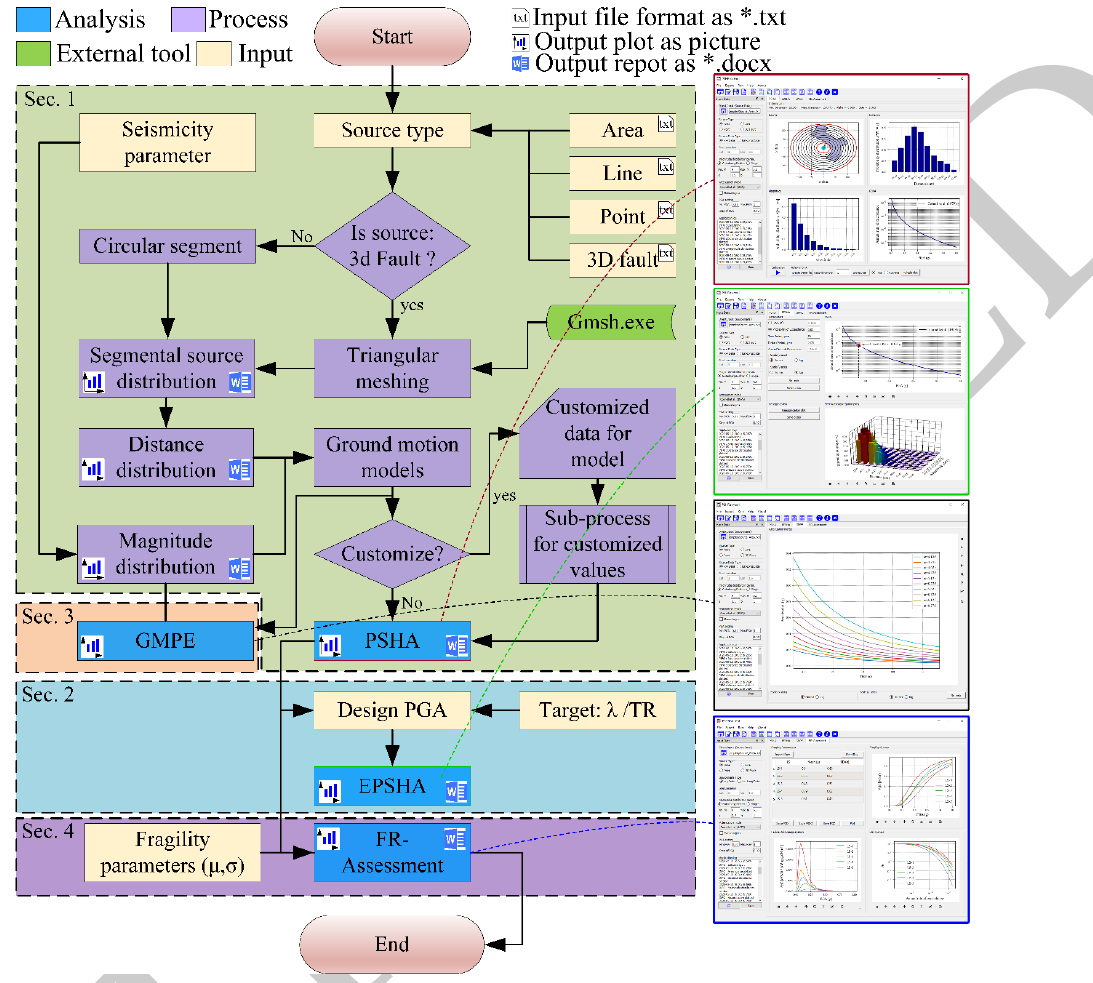
Figure 4. PSHRisk-tool flowchart showing the whole process along with output GUI.